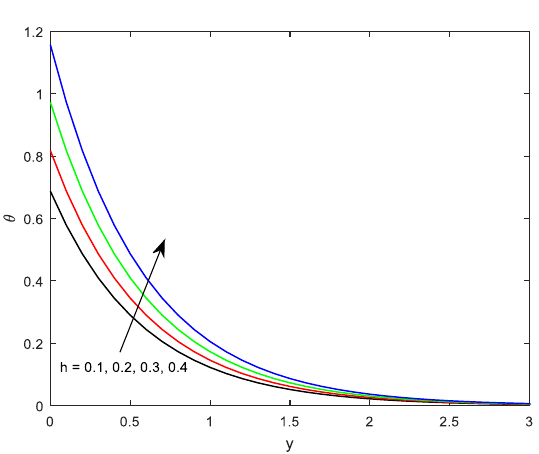
Fig. 9. Profiles of  with a change in